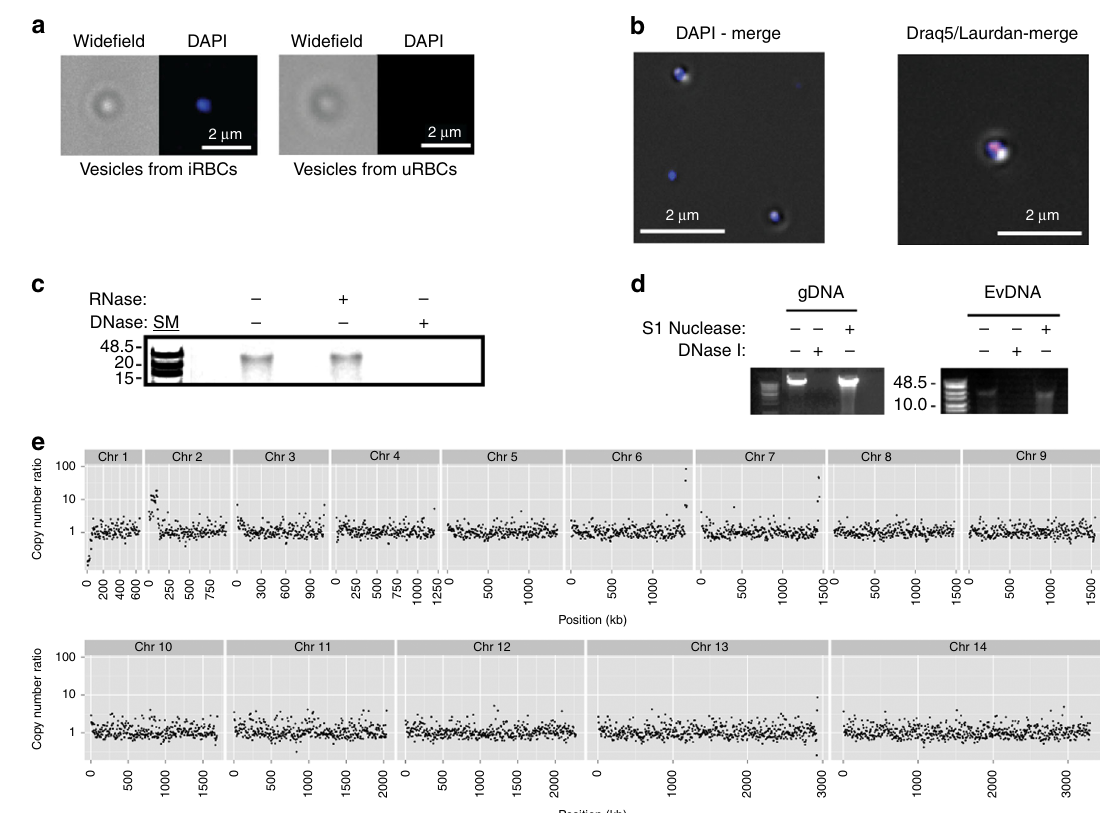
Fig. 3 Parasite EVs released during the early post-invasion stage contain gDNA. a P. falciparum -derived EVs and EVs derived from uRBCs stained with DAPI and wide fi eld merged. b Draq5-red and Laurdan-blue stained EVs (right). c Agarose gel electrophoresis of DNase/RNase-treated or DNase/RNase- untreated Ev-DNA. d DNA extracted from EVs was digested with either S1 nuclease or dsDNase I. Digestion of parasite gDNA serves as control. e Relative copy number fold change (RCNFC) between EV and gDNA control for nuclear